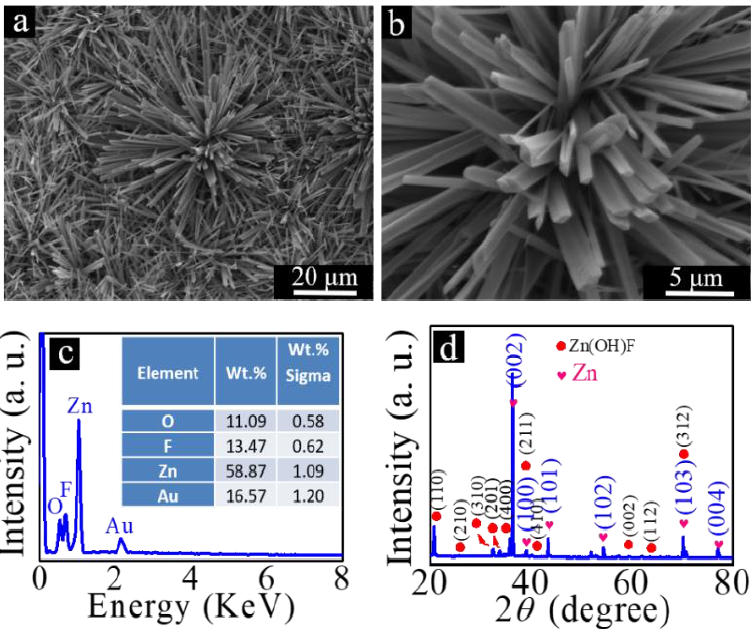
Figure 2. ( a ) Low- and ( b ) high-magnification SEM images of Zn(OH)F synthesized on zinc foil, ( c ) EDX spectrum, and ( d ) XRD diffraction patterns of zinc foil with Zn(OH)F grown on its surface.